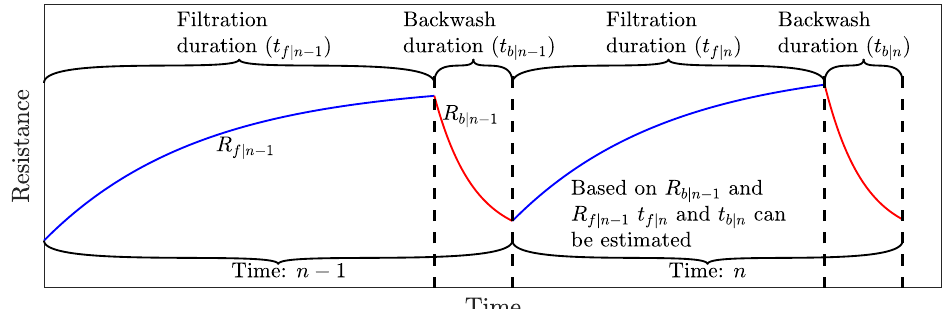
Figure 3. Resistance trend and